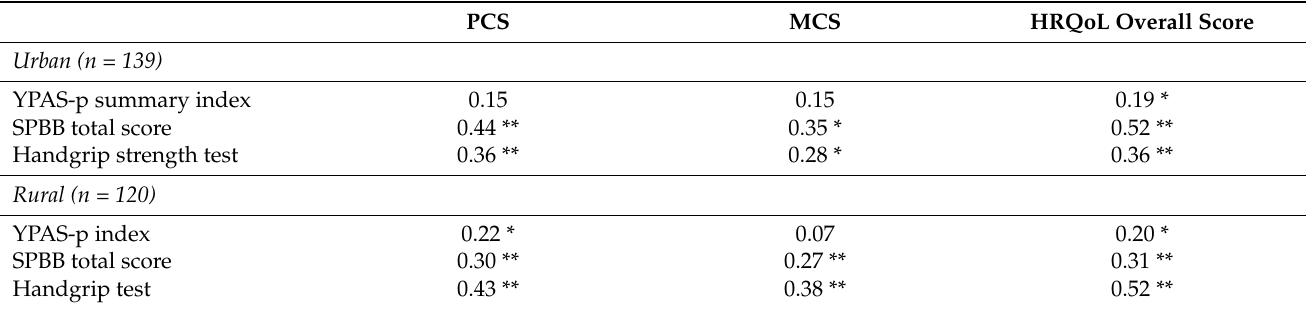
Table 3. Spearman’s correlations between physical-functional tests and health-related quality of life according to the living